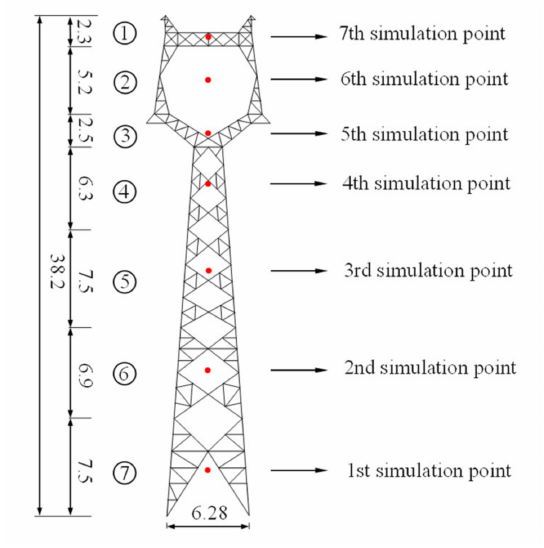
Figure 3. Divisions and simulating points of the studied tower (unit: